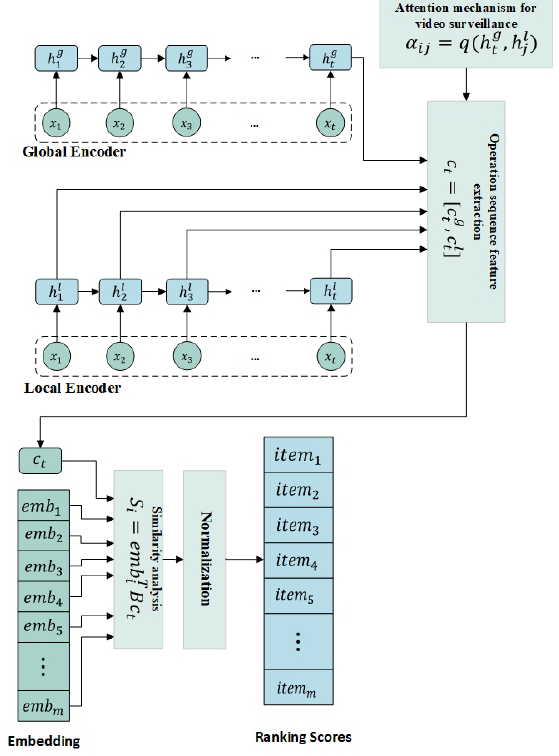
Figure 1. OL-JCMSR